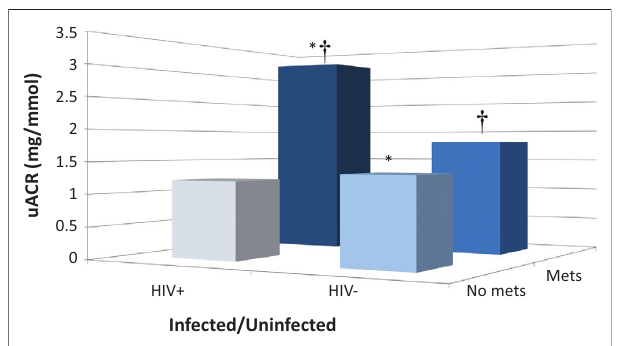
FIGURE 1: Urinary albumin excretion for HIV-uninfected and HIV-infected individuals with and without metabolic syndrome after adjusting for age, sex and waist